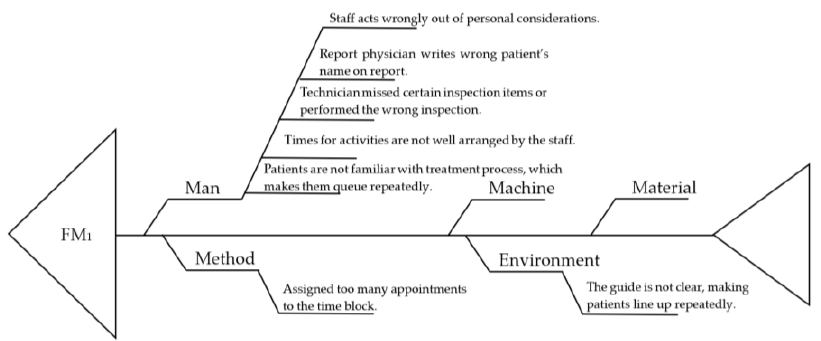
Figure 3. Cause-and-effect diagram enhanced by 4M1E scheme for identifying root causes of failure relevant to FM 1.